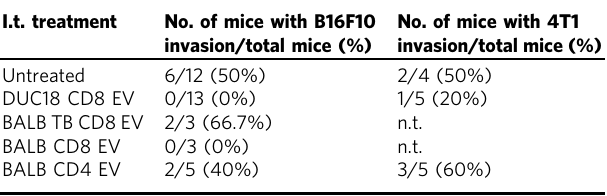
n.t. not tested Number of B16F10- or 4T1-bearing mice with muscle and/or fatty layer invasion beyond the tumour tissues (impossible to remove the subcutaneous tumours surgically) was